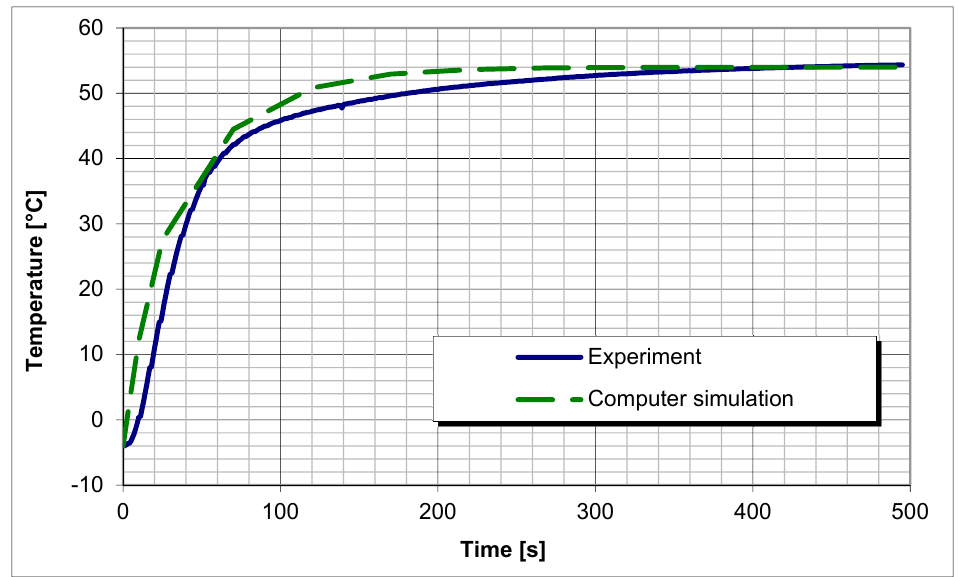
Figure 20. Temperature changes in the rotor during start-up of the M1 satellite motor obtained from an experimental test and computer simulation (initial motor temperature − 4 °C, oil temperature 54 °C, rotational speed in the steady-state conditions 185 rpm).